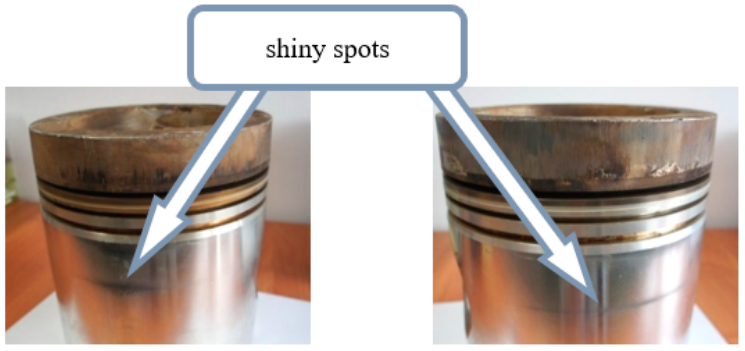
Figure 2. Comparison of the shiny spots of the guiding part of the tested